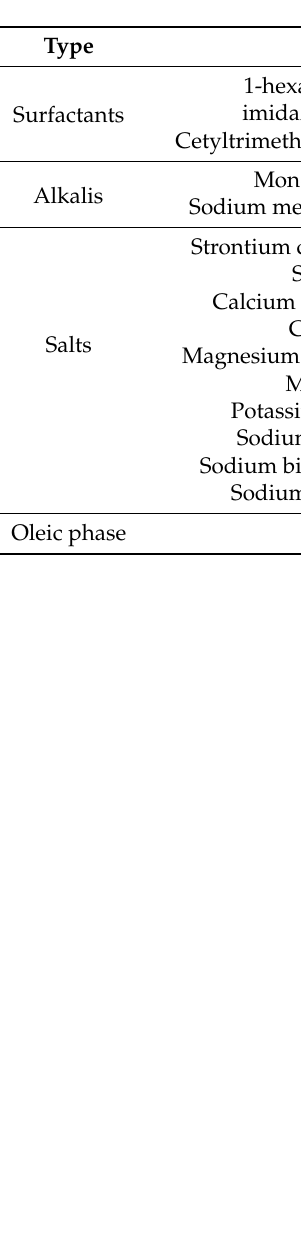
Table 1. Details of the experimental materials.